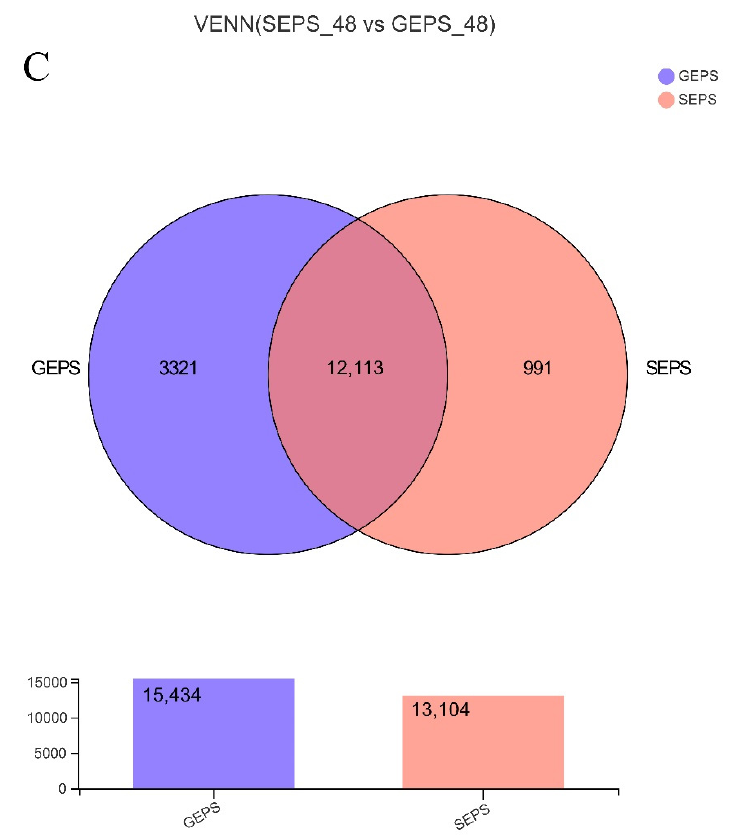
Figure 1. Analysis of DEGs in SEPS_48 and GEPS_48 comparison groups. ( A ) Number of up- and downregulated DEGs in the SEPS_48 and GEPS_48 comparison groups. Red dots represent upregulated DEGs, blue dots represent downregulated DEGs. ( B ) Heatmap of the DEGs in the SEPS_48 and GEPS_48 comparison groups. Red indicates highly expressed genes and blue indicates less-expressed genes. ( C ) Venn diagram of number of DEGs in SEPS_48 and GEPS_48 comparison groups.